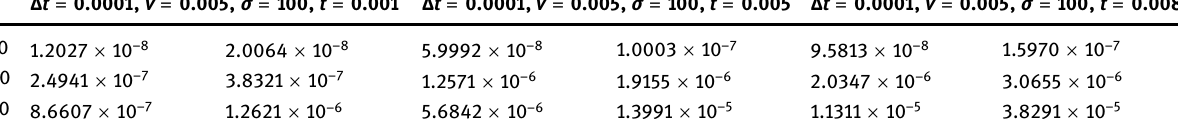
Table 5: L 2 and L ∞ error